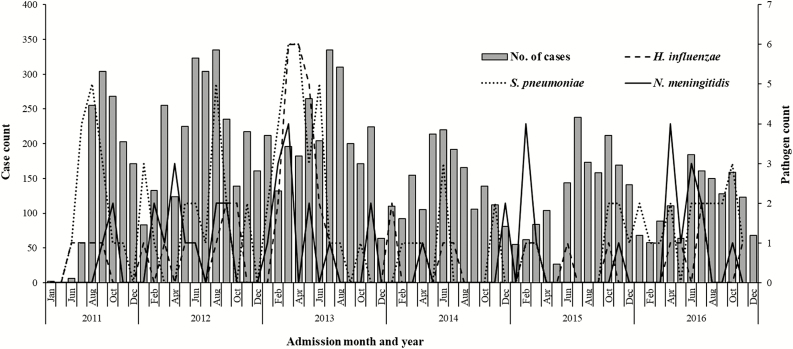
Distribution of pathogens isolated and suspected meningitis cases admitted to hospital in the Republic of Benin by month and year for the period 2011–2016.